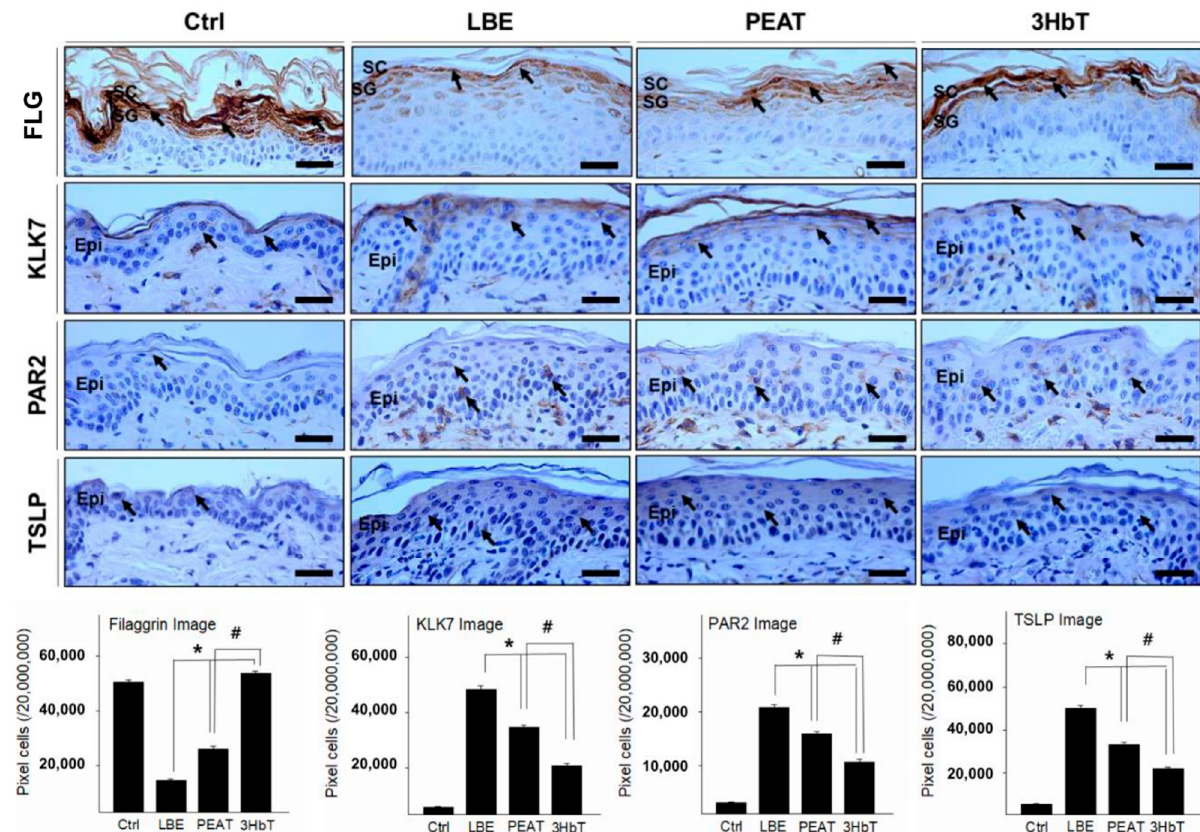
Figure 4. The regulation of filaggrin and inflammation using Three Herb (3Hb) extract. The expression of FLG was significantly higher in 3HbT compared to PEAT and LBE. The expression of KLK7, PAR-2, TSLP (light brown particles indicated by arrows) was significantly lower in 3HbT compared to PEAT and LBE (immunohistochemistry; bar size, 50 µm). The data of image analysis for positive reaction showed the same results. 3Hb, Rhizome of Coptis chinensis , Rhizome of Glycyrrhiza uralensis , and fermented Semen of Glycine max ; FLG, Filaggrin; Ctrl, the normal group; LBE, lipid barrier elimination group; 3HbT, 3Hb treated group after lipid barrier elimination; KLK7, kallikrein7; PAR-2, protease-activated receptor-2; TSLP, thymic stromal lymphopoietin; Epi, epidermis; * p < 0.05 compared to LBE; # p < 0.05 compared to PEAT.